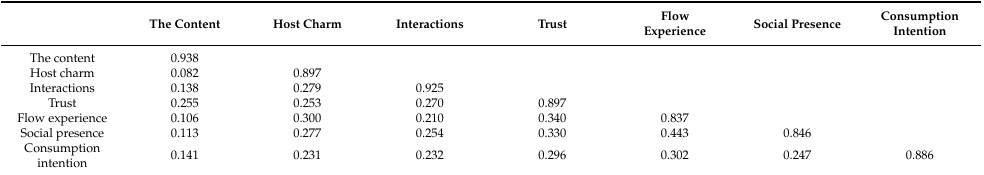
Table 2. Analysis of discriminant